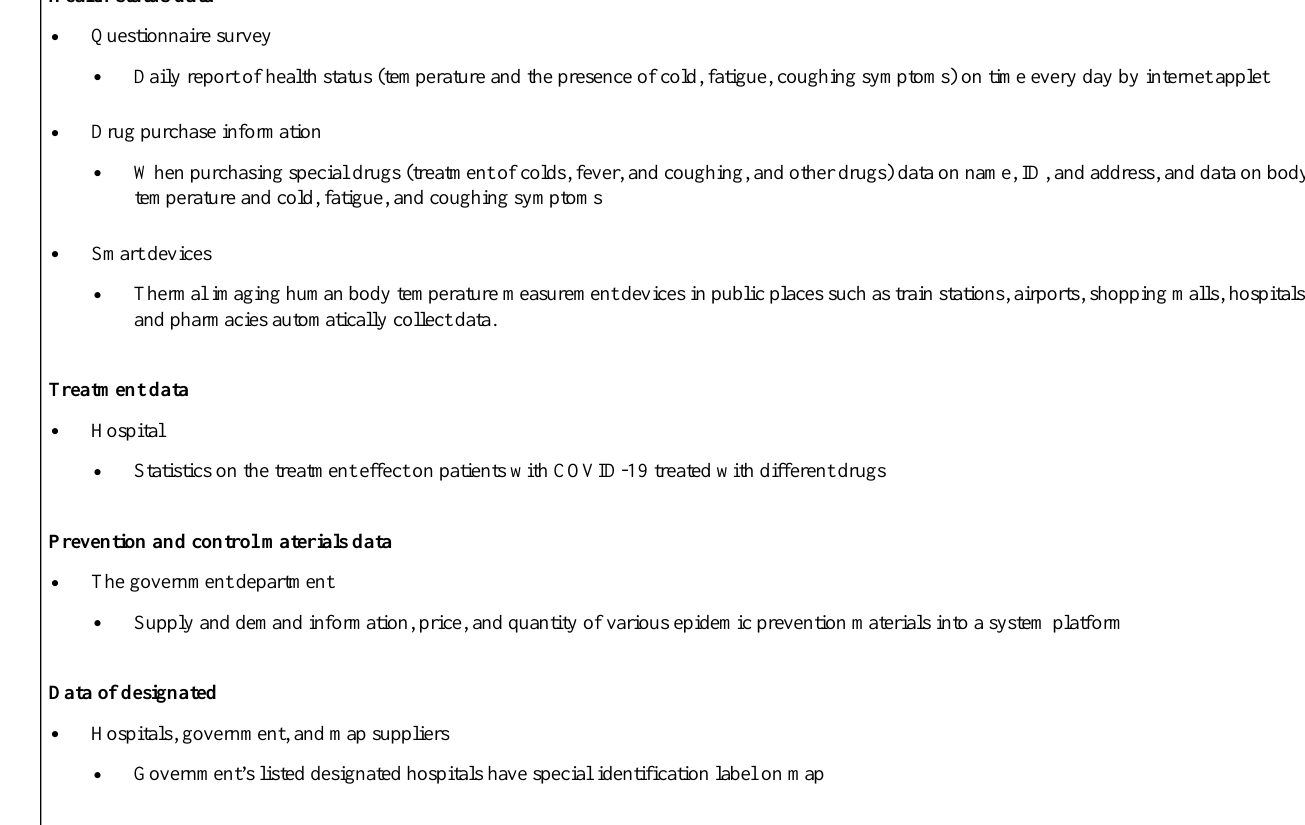
Figure 1 sets out a diagrammatic representation of the conceptual basis of big data technology for COVID-19 prevention and control on four levels: application, analysis, data, and